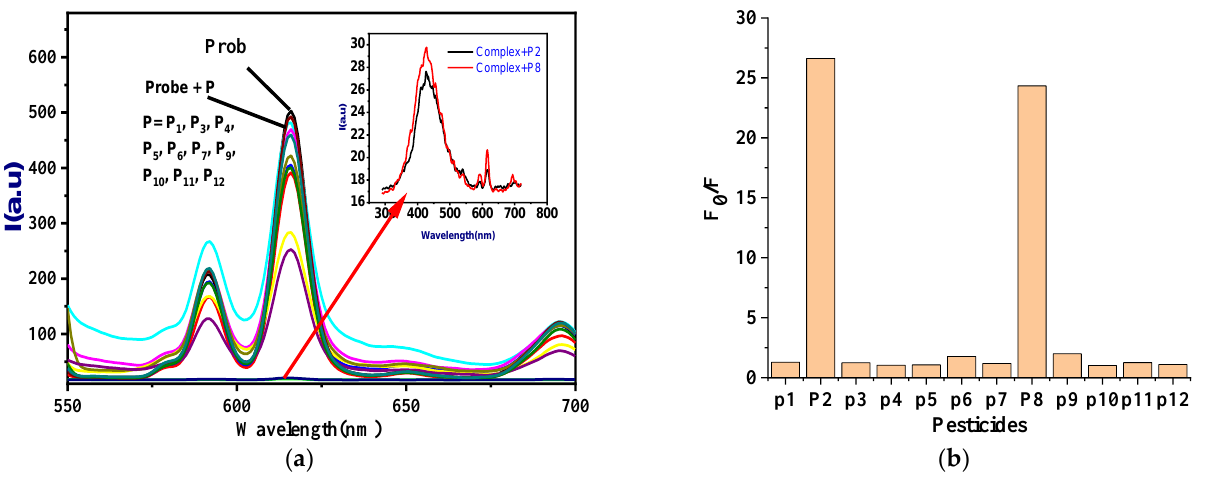
Figure 5. The luminescence spectra of 2.5 × 10 − 5 mol. L − 1 Eu (III) – complex with 2.5 × 10 − 5 mol. L − 1 of different pesticides in a methanol medium, λ ex = 268 nm, at room temperature. Azinphos-ethyl (P1), chlorfenvinphos (P2), chlorpyrifos (P3), crotoxyphos (P4), diazinon (P5), dichlorvos (P6), isofenphos (P7), malathion (P8), paraoxon-ethyl (P9), phosdrin (P10), endosulfan (P11), and heptachlor (P12).